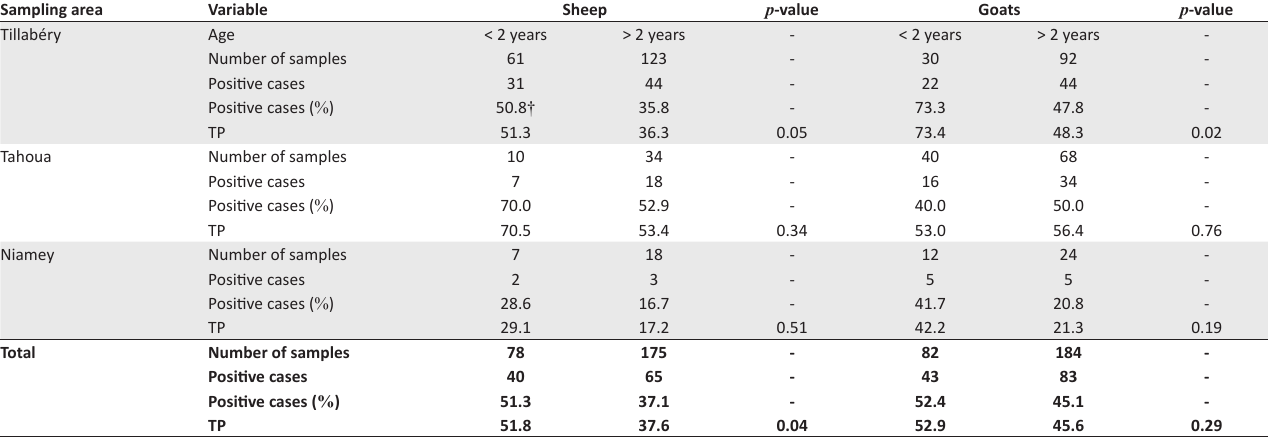
TABLE 4: Prevalence of peste des petits ruminants in sheep and goats according to age. Sampling